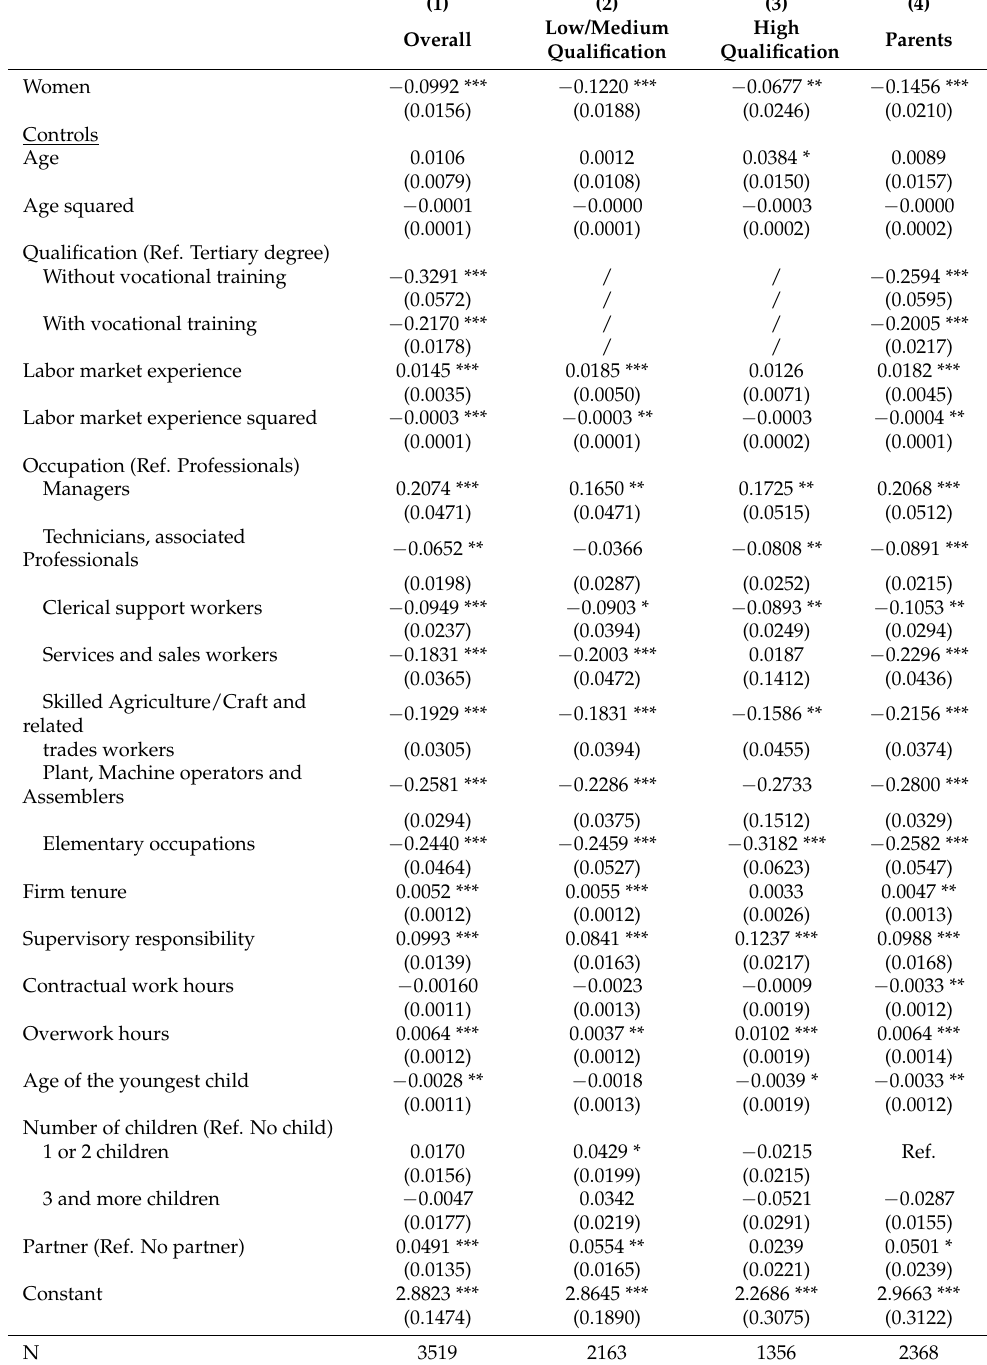
Table A11. Association of gender and log hourly wages within organizations with at least one EQM, including control